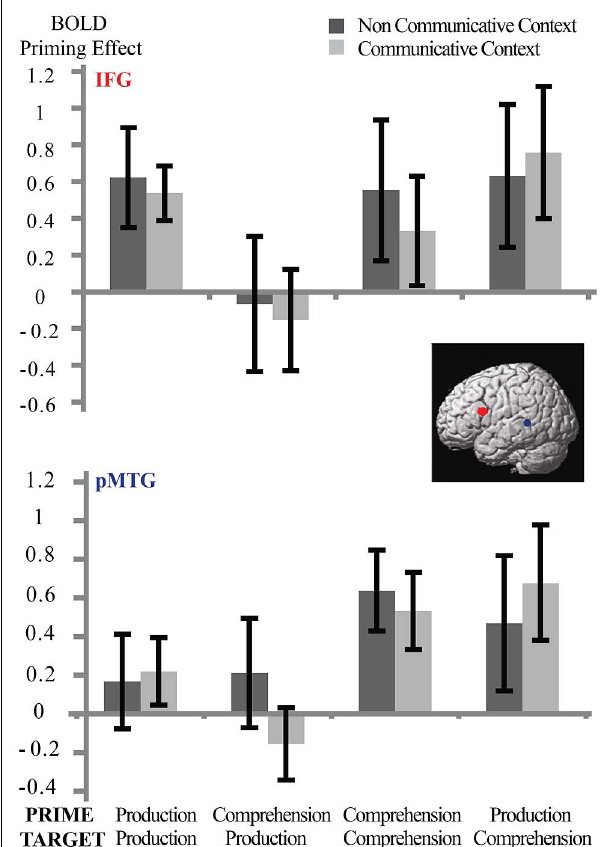
FIGURE 5 | Between-context analysis (3): ROI-analyses in two clusters based on Menenti etal. (2011): left inferior frontal gyrus (top) and left pMTG (bottom). Error bars reflect standard errors.There is a main effect of Syntactic Repetition in both clusters but no interaction with Context: participants in the non-communicative and communicative condition do not differ in the strength of their repetition suppression effects in these regions.